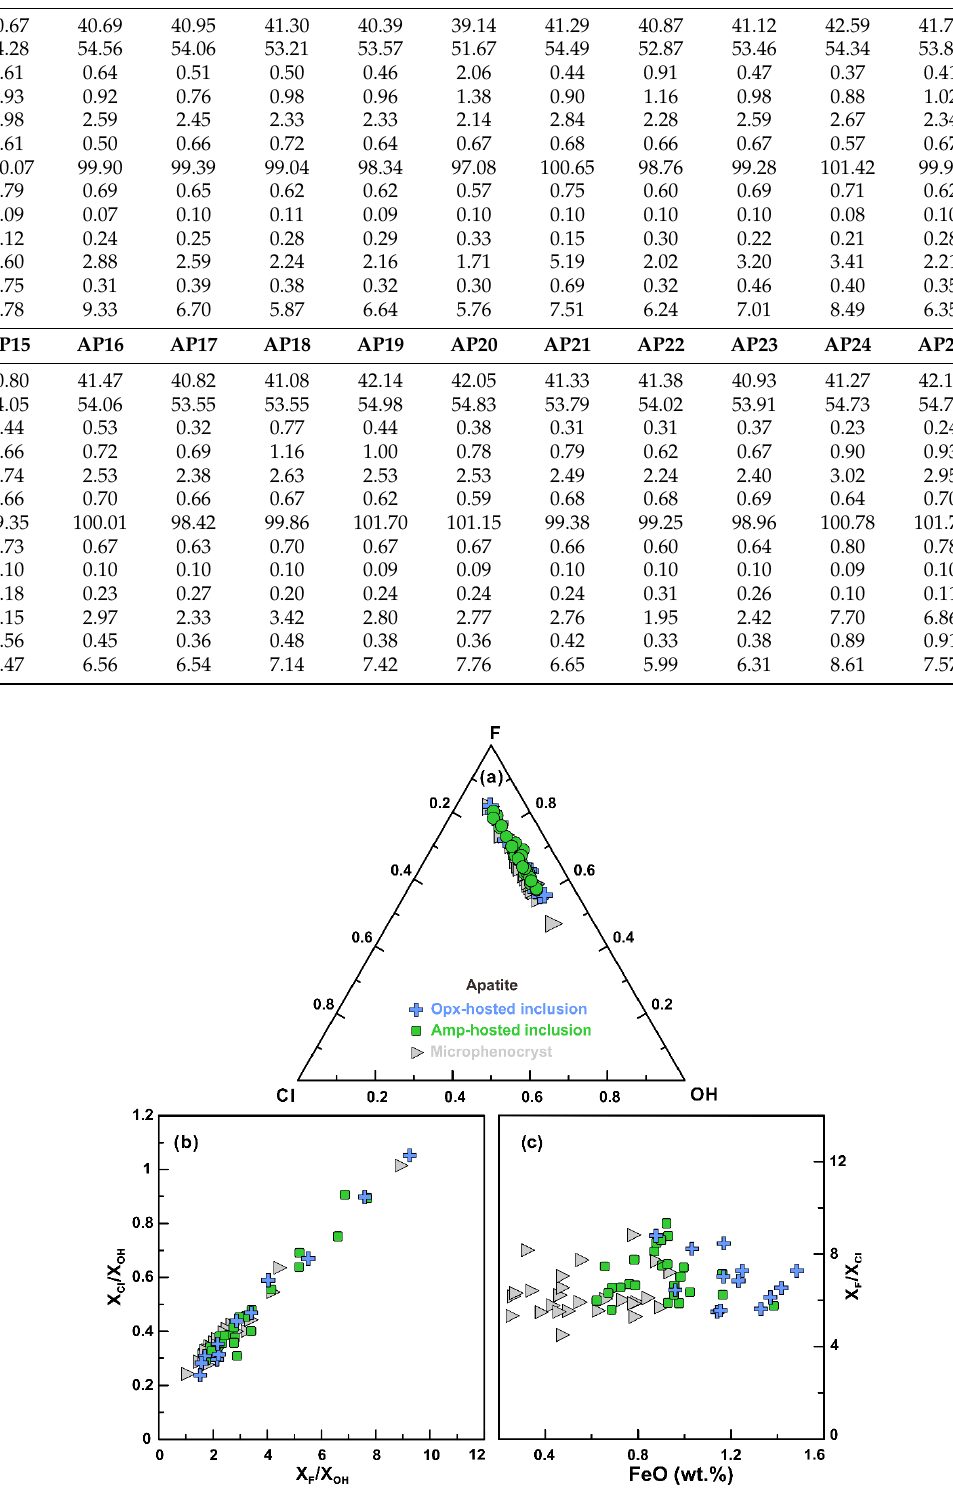
Figure 3. Volatile compositions of orthopyroxene- and amphibole-hosted apatite inclusions and apatite microphenocrysts in the rhyolite from the Yonaguni Knoll IV hydrothermal field. Data are depicted in the ternary diagram of Cl–OH–F ( a ) and binary plots of X Cl /X OH vs. X F /X OH ( b ), and X F /X Cl vs FeO ( c ). Table 2. Major and volatile element analyses of the amphibole-hosted apatite inclusions (wt.%).